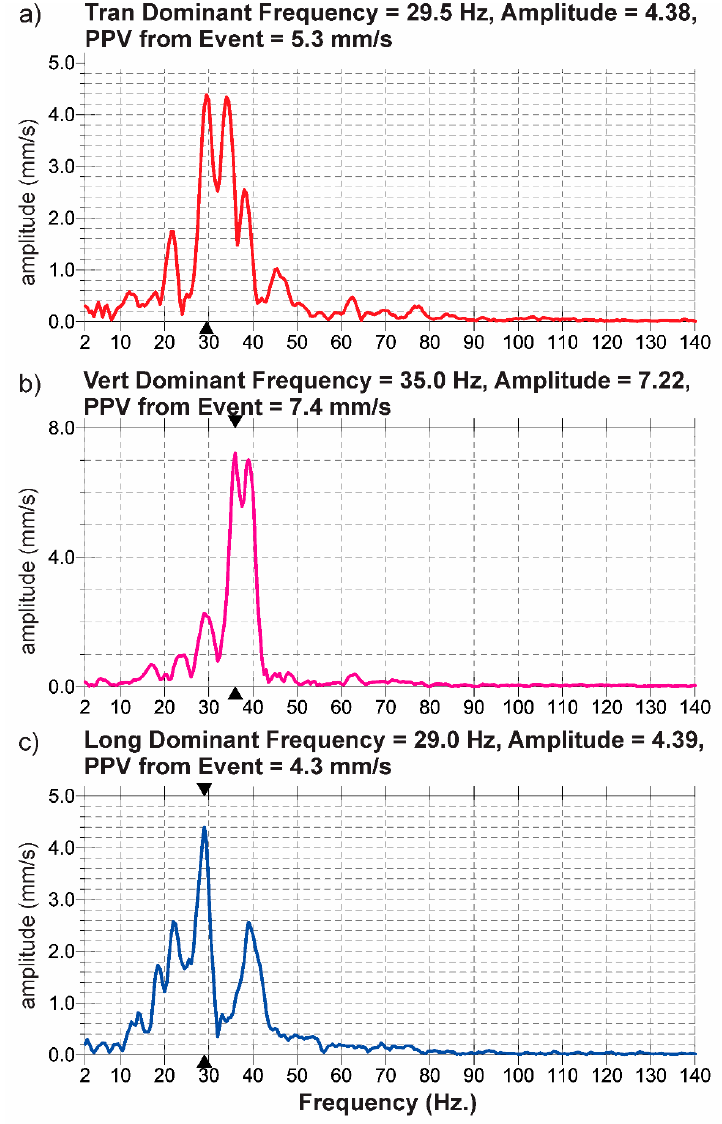
Figure 4. Records of vibrations caused by blasting event. ( a ) transverse vibrations, ( b ) vertical vibrations and ( c ) longitudinal vibrations.